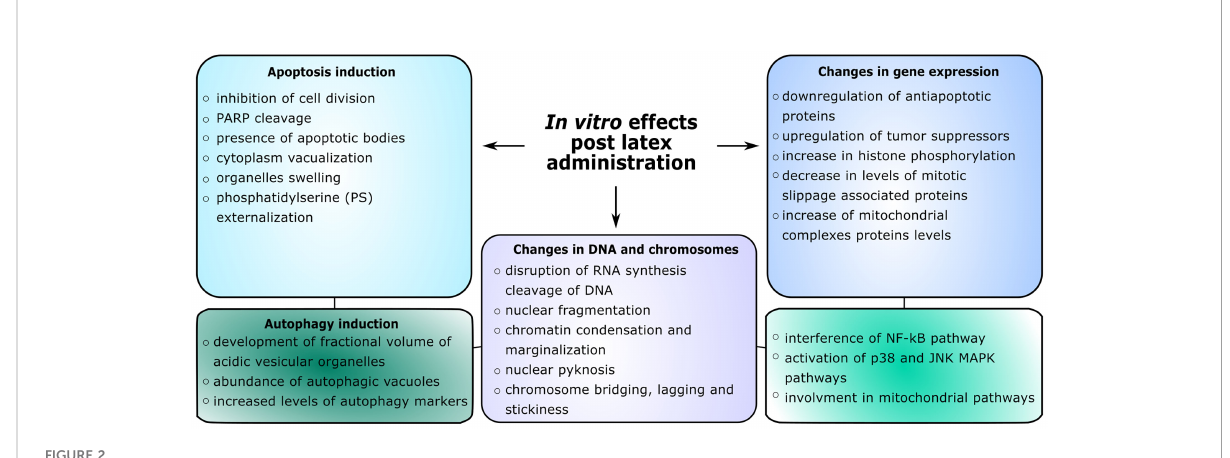
FIGURE 2 Overview of in vitro effects on cells after administration of plant latex extracts or its